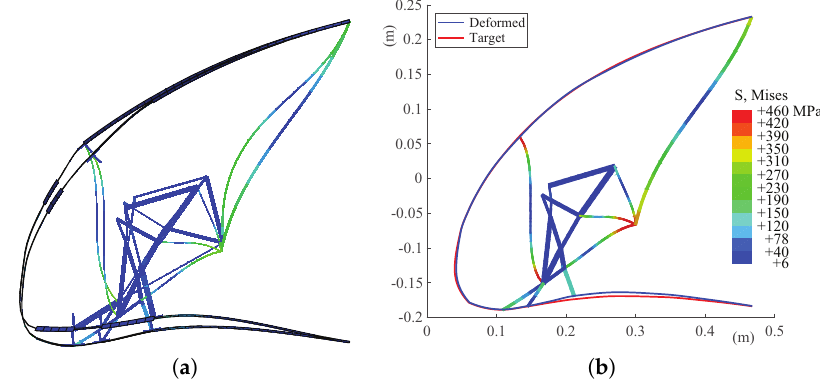
Figure 17. NiTiNOL: deformation of the initial and optimal solutions ( a ); Von Mises stress in the rib and comparison between the optimal deformation and the target shape ( b ).